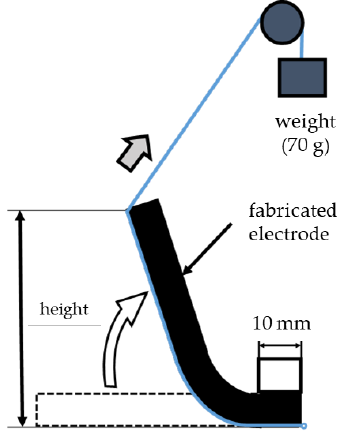
Figure 2. Schematic diagram of the electrode manufacturing apparatus (redrawn from Hatakeyama et al., 2017).